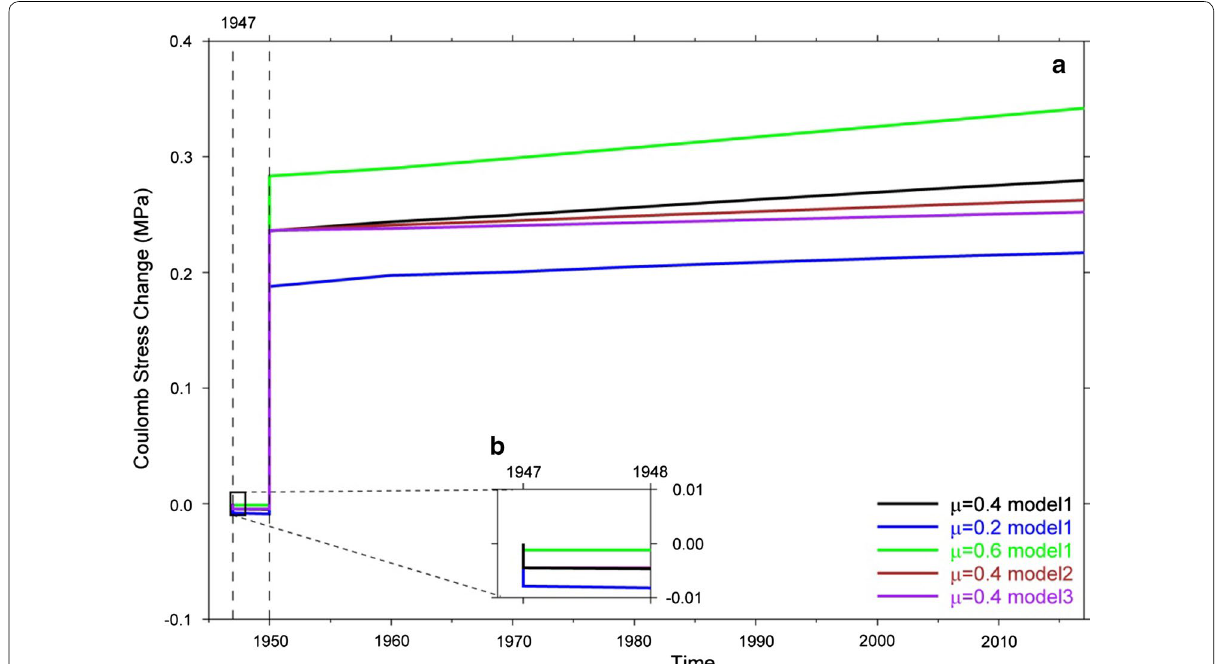
Fig. 6 a Coulomb stress evolution at the epicenter of the 2017 Mainling earthquake caused by historical earthquakes. Lines labeled in different colors represent results calculated with different parameters. Model 1, model 2 and model 3 indicate different viscosity coefficients, which are listed in Table 3. b Enlarged drawing for the period of